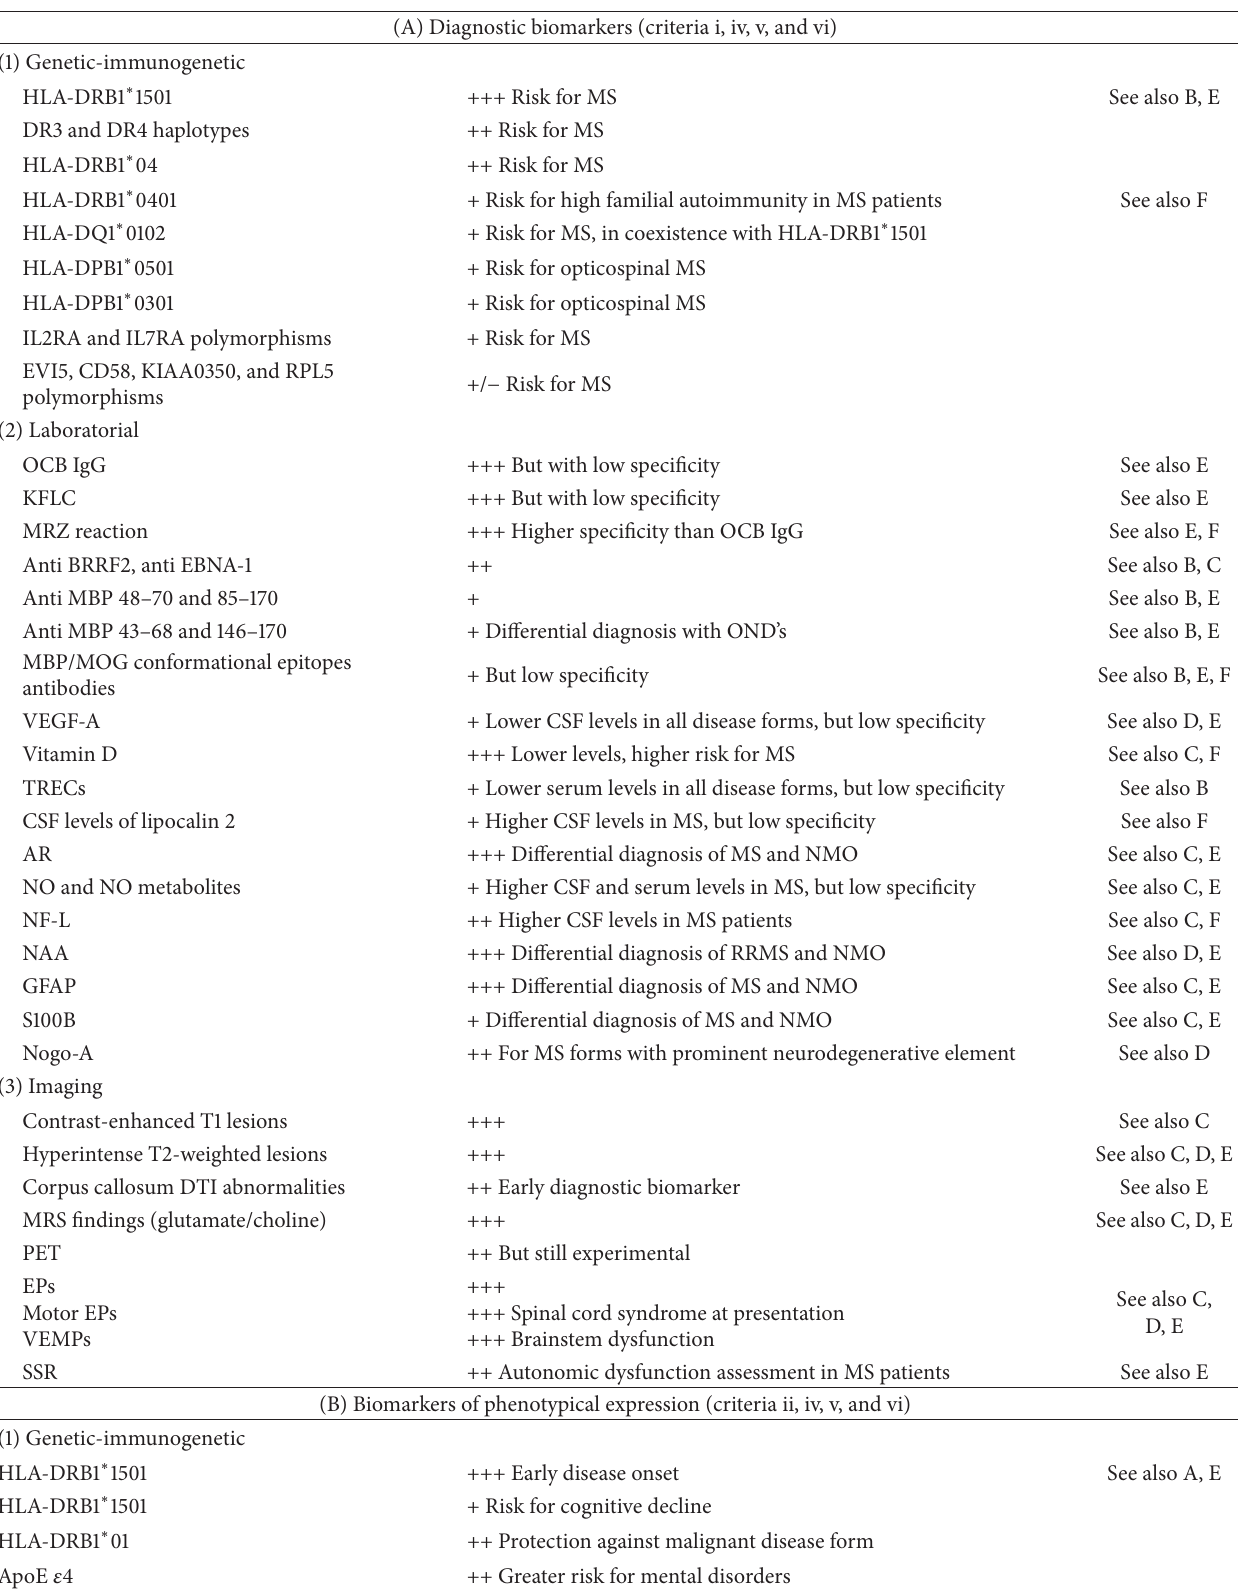
Table 1: Biomarkers in